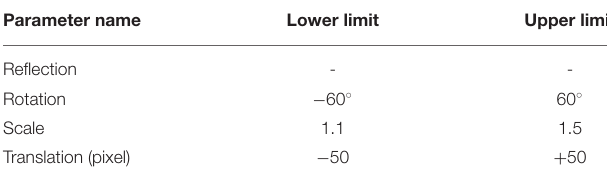
TABLE 2 | For the training of the SegNet network, the parameters determined before the training.